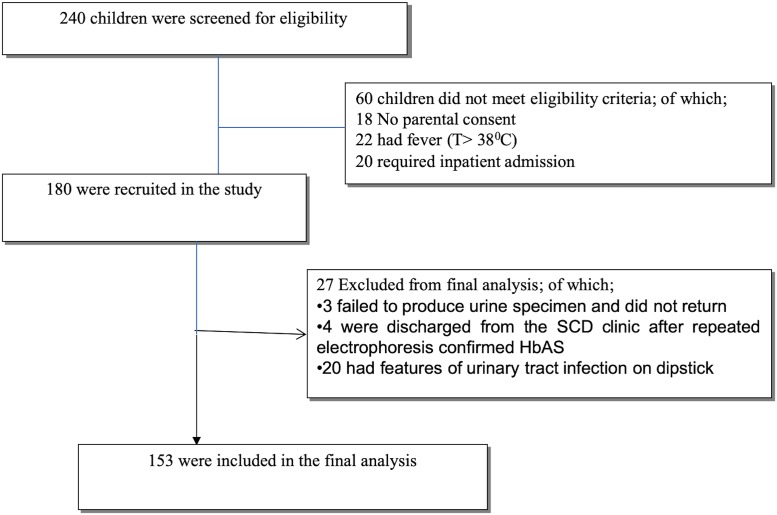
A consort diagram of the study enrollment break down.